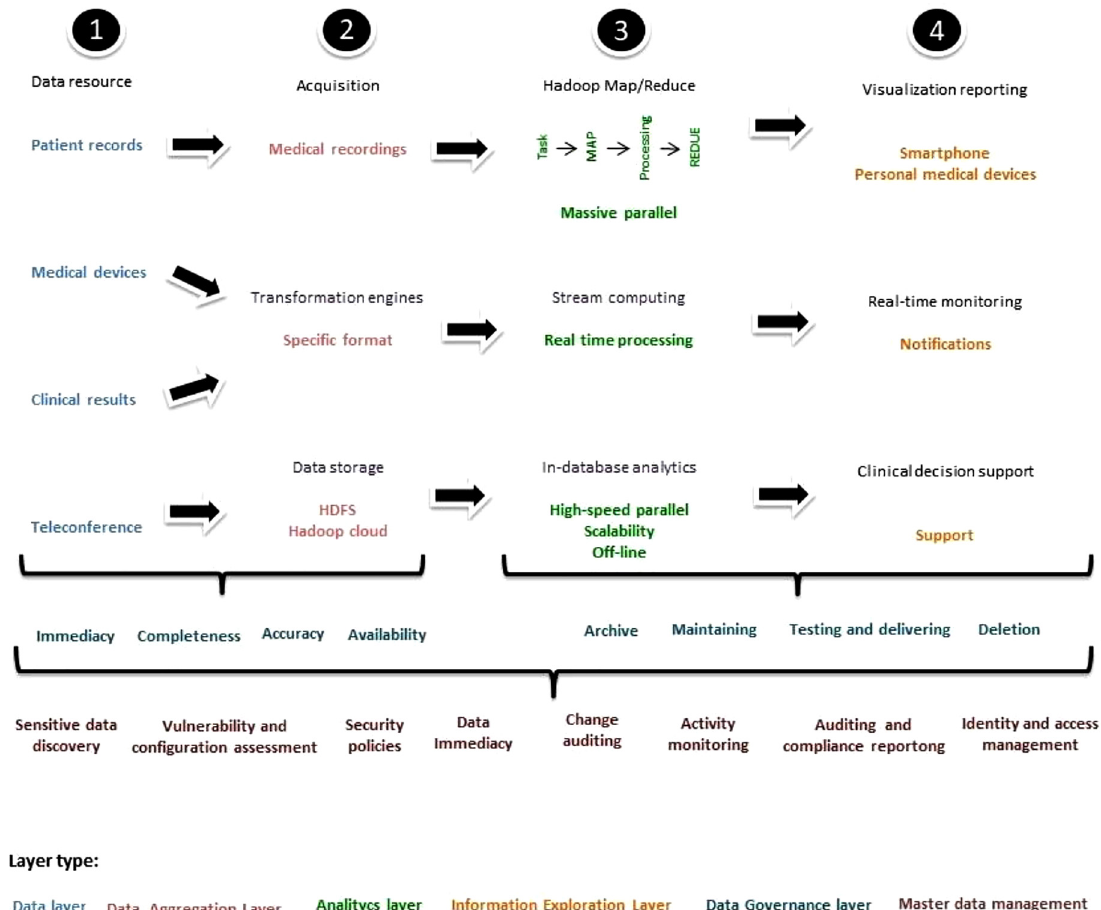
Figure 2: Big data analytics architecture in healthcare. The architecture of big data rule by the capture, transformation consumption and data management regulation. The first process consists of the recollection of structured, semi-structured and unstructured information from different devices. Then, the information is converted in specific formats and stored. Later, the data is processed by map/reduce other programming models which analyze different features of the data according to the needs of the user; early outputs are generated. Finally, more convoluted outputs are created and delivered to electronic devices. All the processes are based on data security statutes, master data management and data life-cycle management, ensuring the good quality and the correct use of the